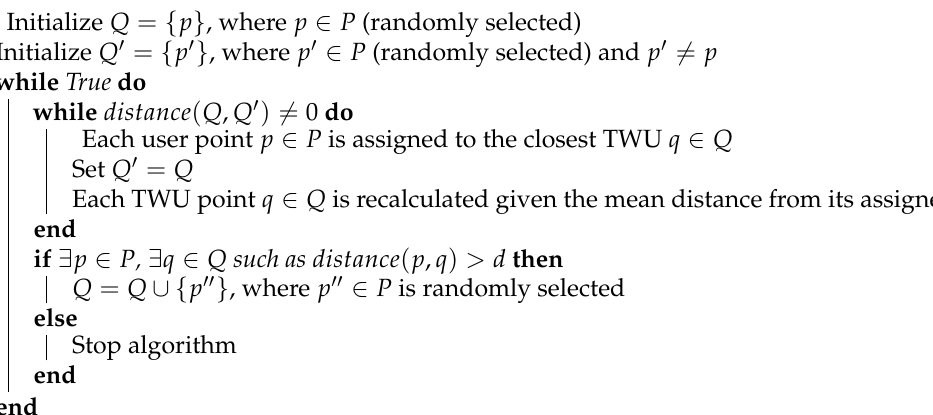
Figure 2. TWUs deployment scenarios: ( a ) small area with a single TWU providing communication to members of a SAR team; ( b ) large area supported by a single TWU; in this case, nodes count on weak or no communication signal to interact among them; and ( c ) large area with four TWUs that can provide adequate communication with bounded delay; this is an example of a feasible solution to cover large areas. Algorithm 1 Initial placement of TWUs in a given the emergency area Data : Set P as the current locations of user nodes and maximum transmission distance d Result : Set Q as the locations of the TWUs (cluster